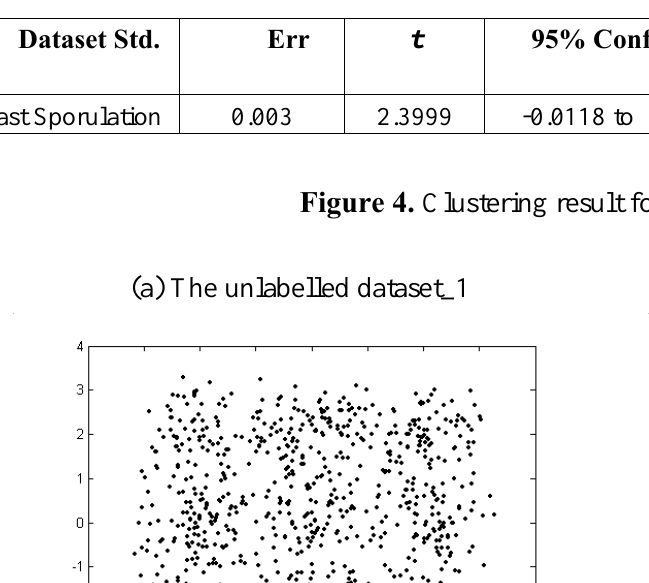
Table 5. Unpaired t- test results for Silhouette index